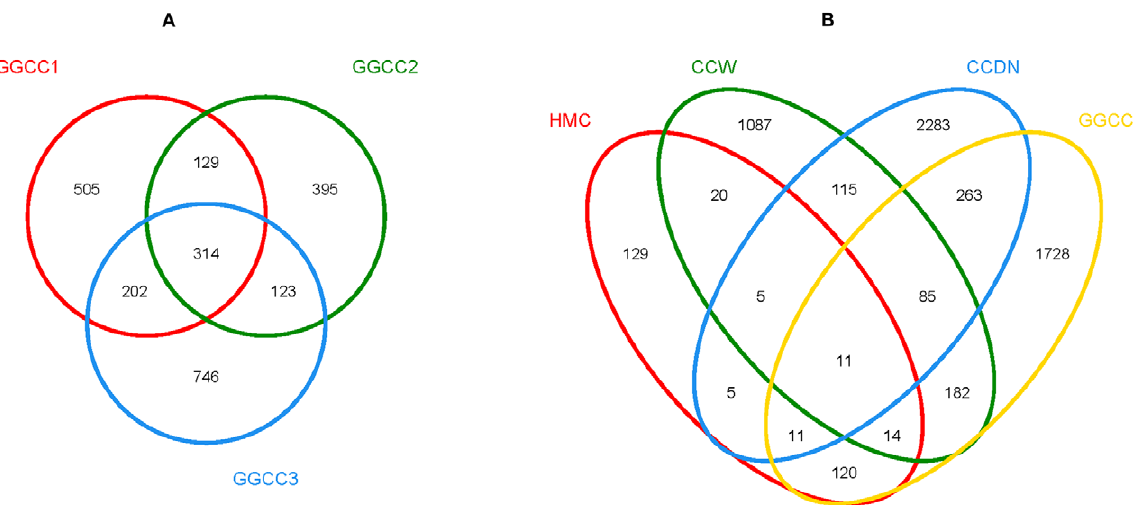
Figure 3. Shared OTU analysis of the different libraries. Venn diagram showing the unique and shared OTUs (3% distance level) in the different libraries (A) for the GGCC1, GGCC2, and GGCC3 libraries, and (B) for the HMC, CCW, CCDN, GGCM and GGCC libraries. * GGCC represents GGCC1, GGCC2 and GGCC3; GGCC1, GGCC2 and GGCC3 mean intestinal content of different individuals of grass carp. HMC, GGCM, CCDN, and CCW stand for grass carp feed ryegrass, intestinal mucosa of grass carp, pond sediment and pond water, respectively.